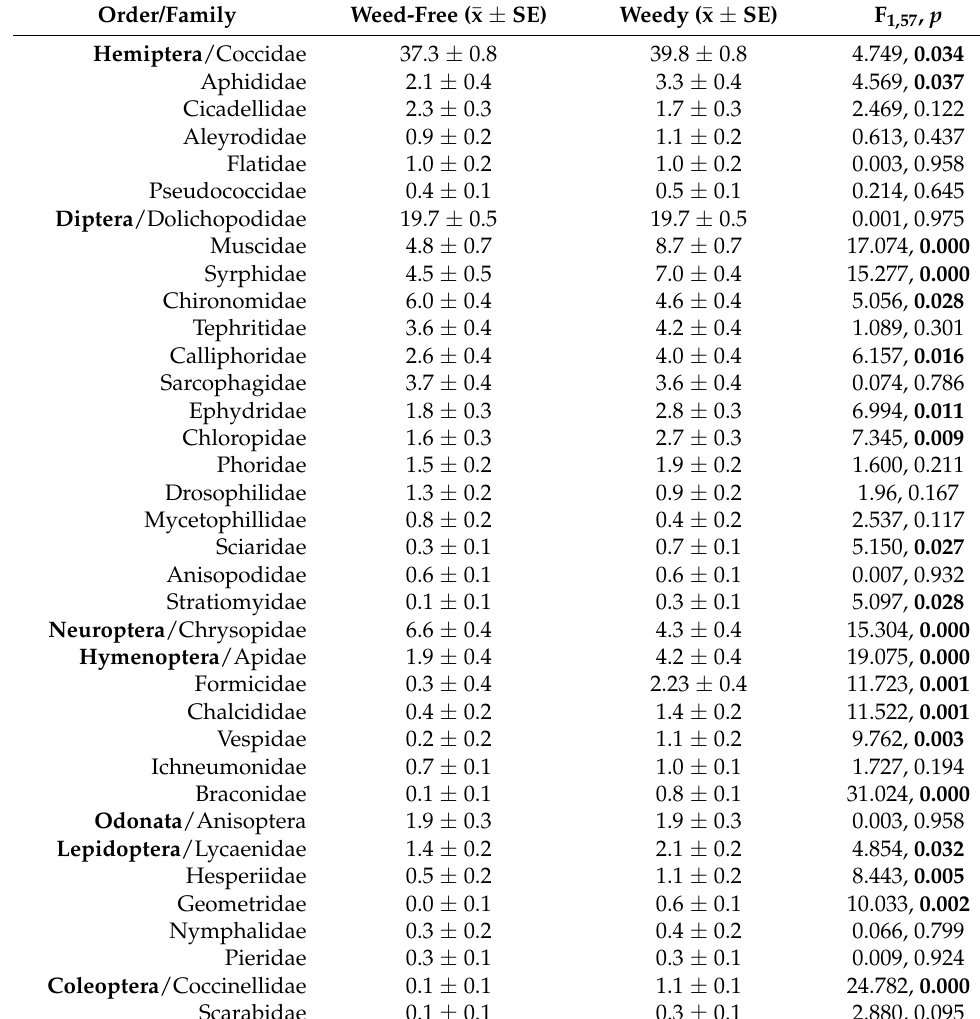
Table 3. Average number of individuals of insect families on individual mango trees with/without weeds, arranged by order and abundance. Significant differences have p -values in bold, as shown by GLM MANOVA. N = 30 trees for each